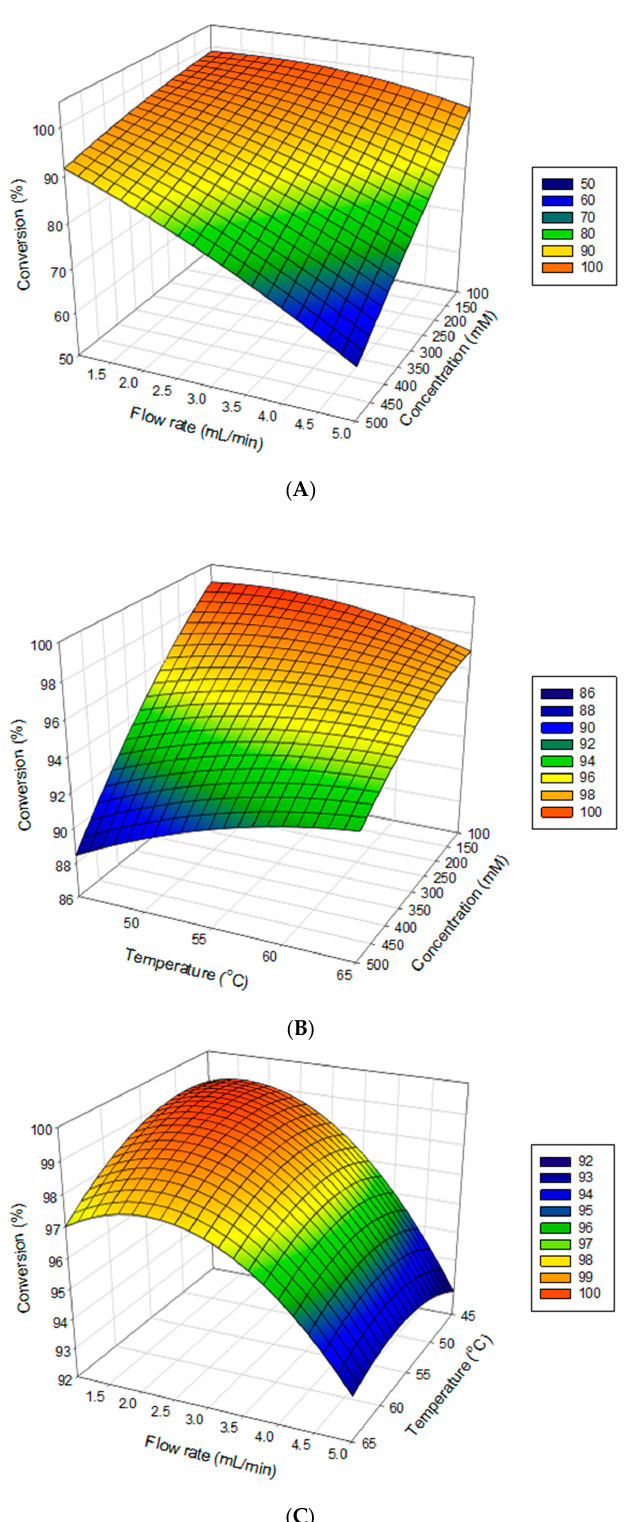
Figure 4. Response surface plots show the mutual effects of reaction ( A ) flow rate and concentration of 2-PE at a temperature of 55 °C; ( B ) temperature and concentration of 2-PE at a flow rate of 1 mL min − 1 ; ( C ) flow rate and temperature at a 2-PE concentration of 100 Mm.